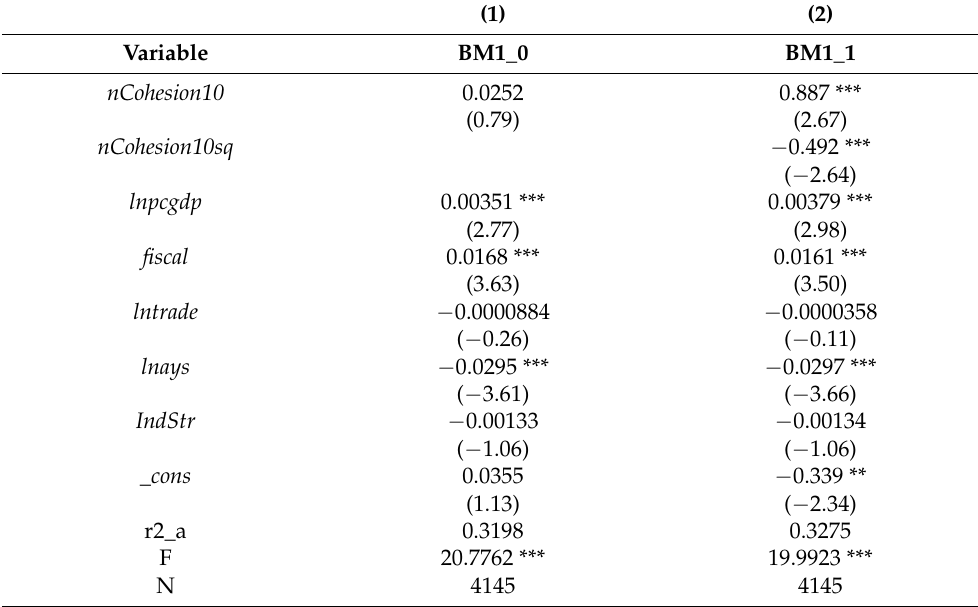
Table 2. Impact of city shape on urban